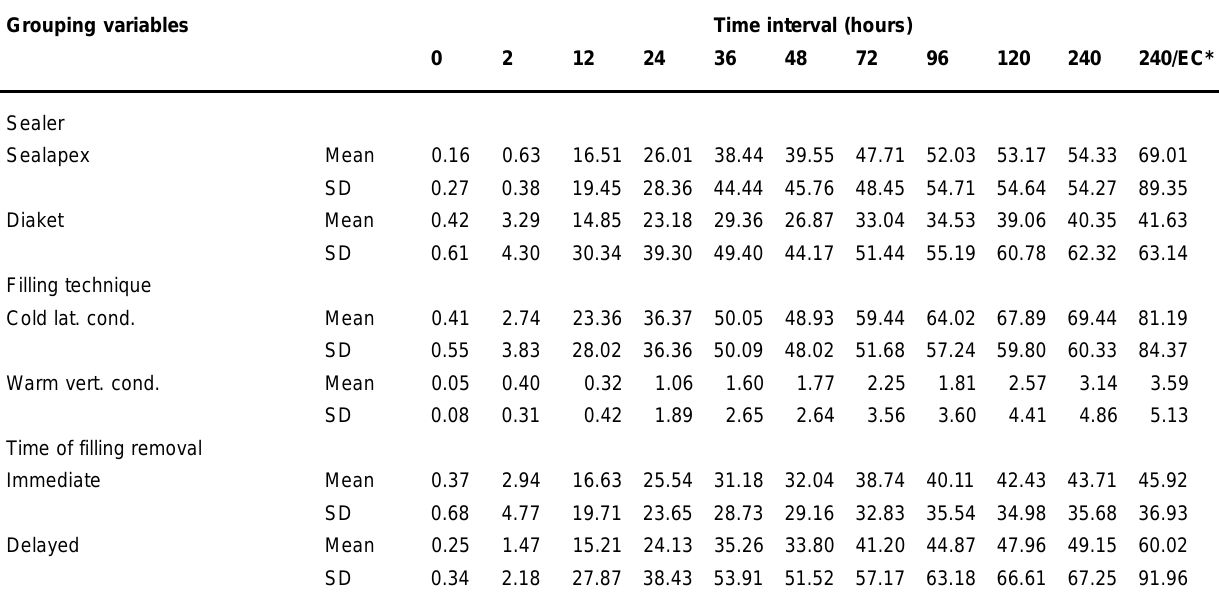
* EC= Electrical current (50 Hz.44